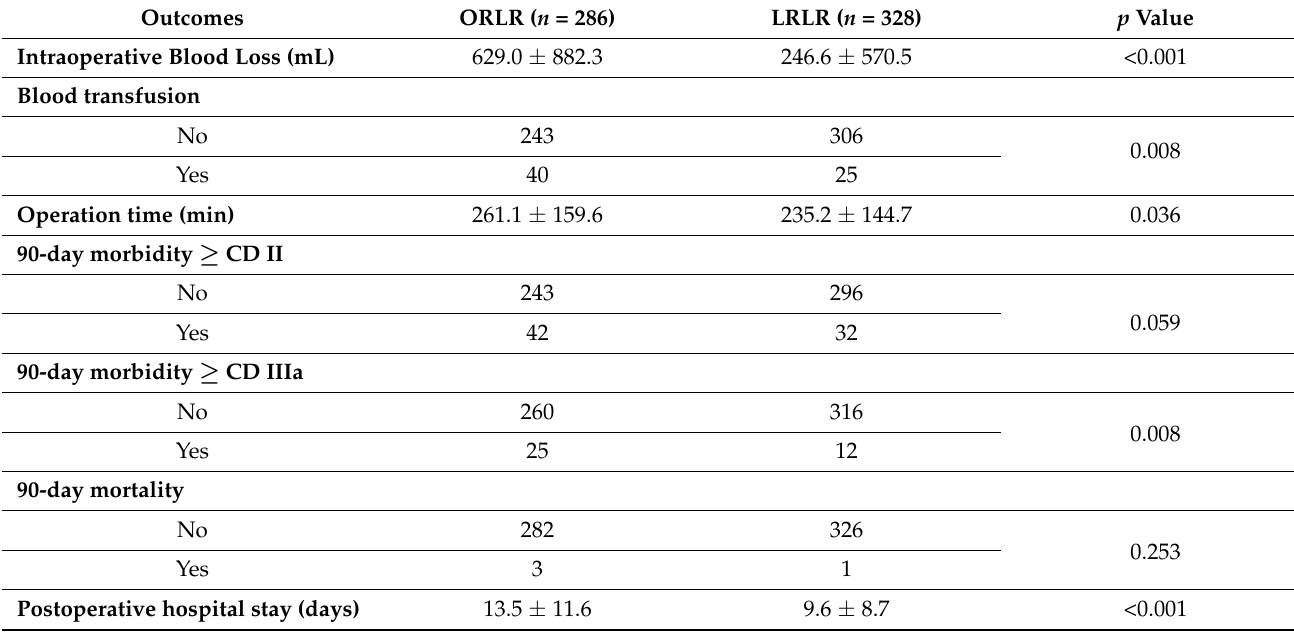
Table 2. Short-term outcomes before propensity score